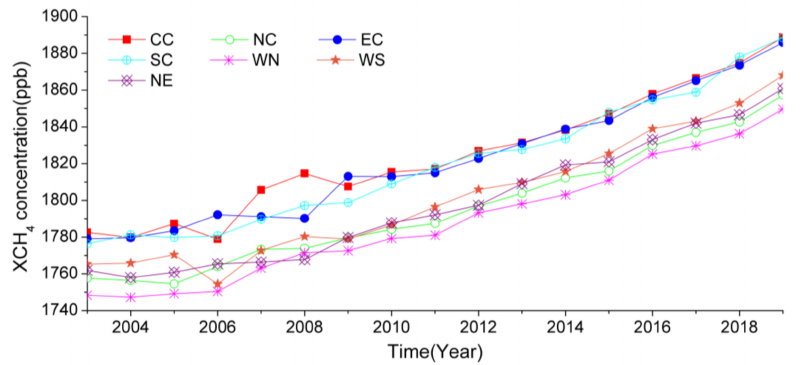
Figure 4. Variation trend of the annual average concentration of XCH 4 in 7 regions in China